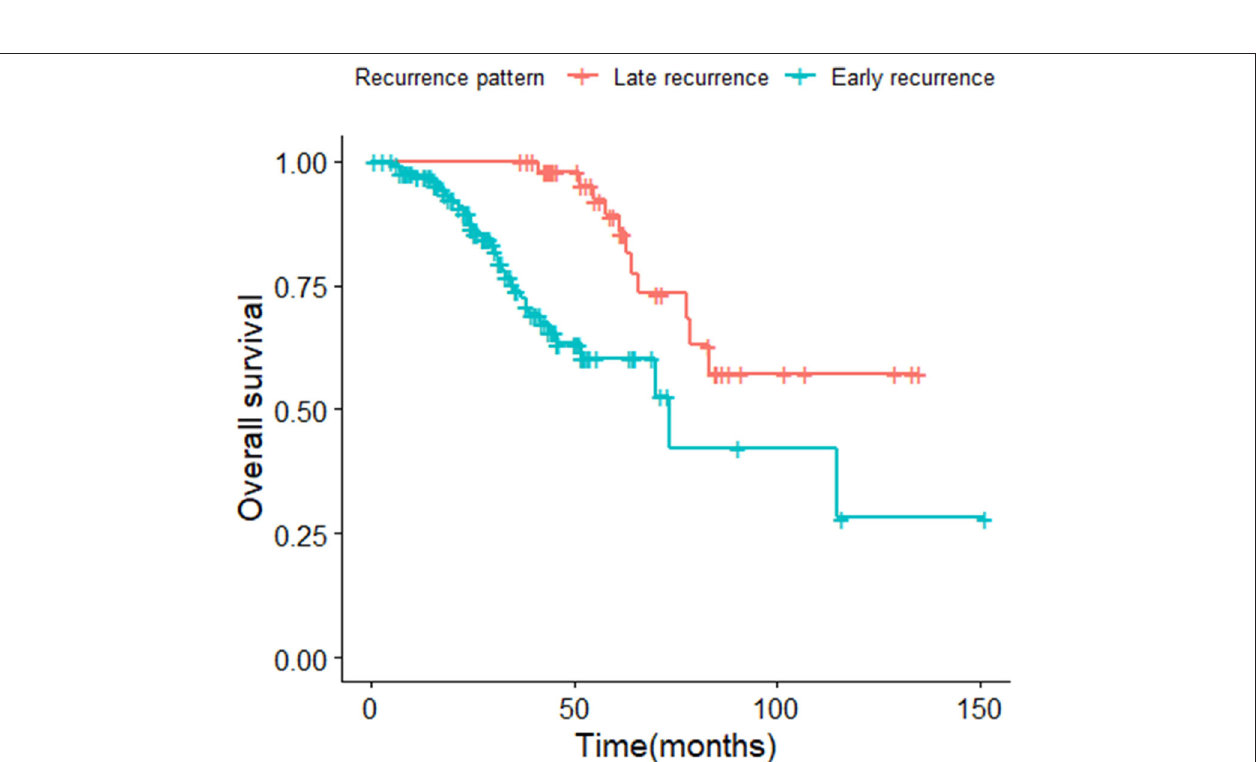
FIGURE 4 | Kaplan-Meier curve of overall survival for patients with early and late relapse ( p < 0.001).